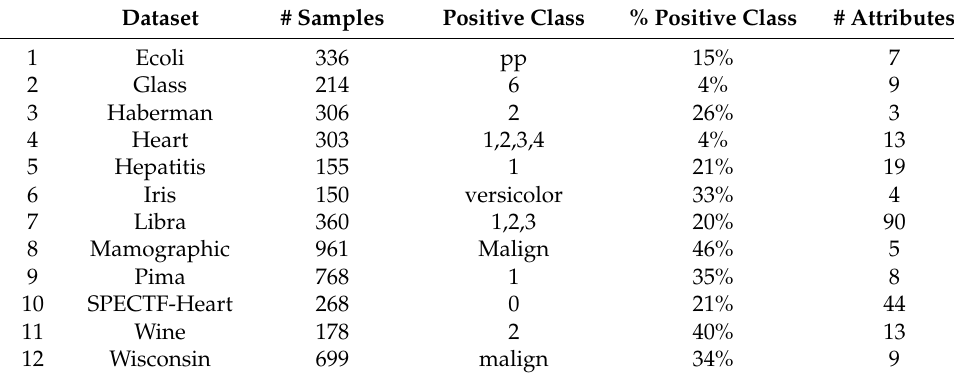
Table 2. Summary of the UCI tables used in this experiment.